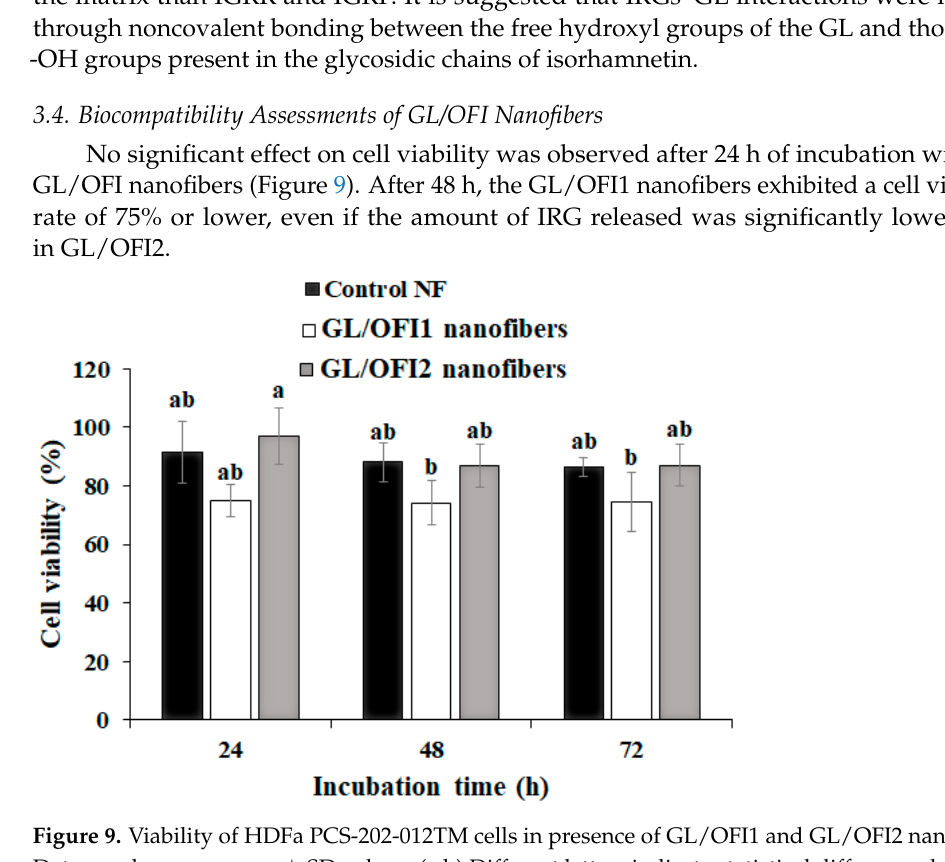
Figure 8. Release kinetics of different isorhamnetin glycosides: ( a ) IGRR, ( b ) IGRP, ( c ) IGP, ( d ) IGR, ( e ) IHMP] from GL/OFI1 or GL/OFI2 nanofibers. GLU : Glucose; RHA : Rhamnose; PEN : Pentose; HEX : Hexose; MP : Methyl pentose.